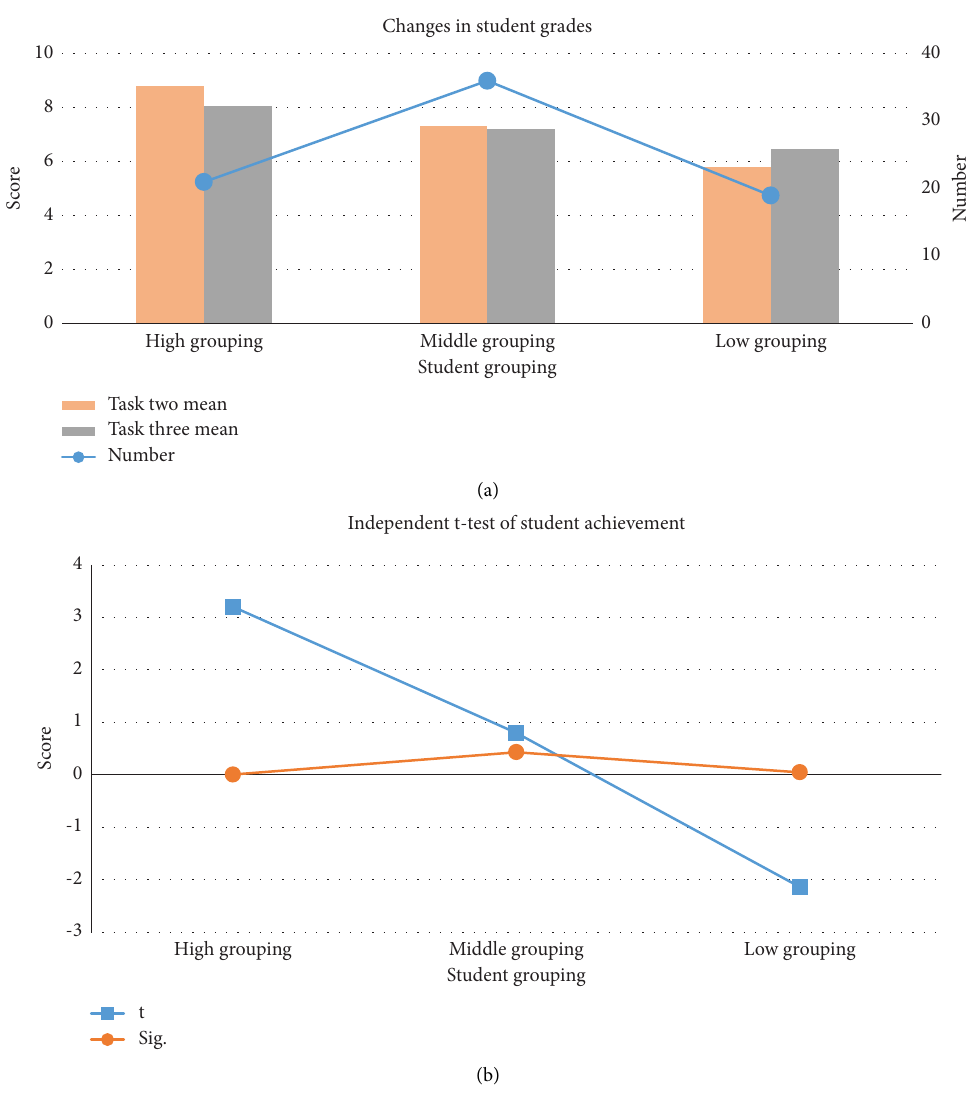
Figure 13: Graph of survey results: (a) changes in grades and (b) independent t -test